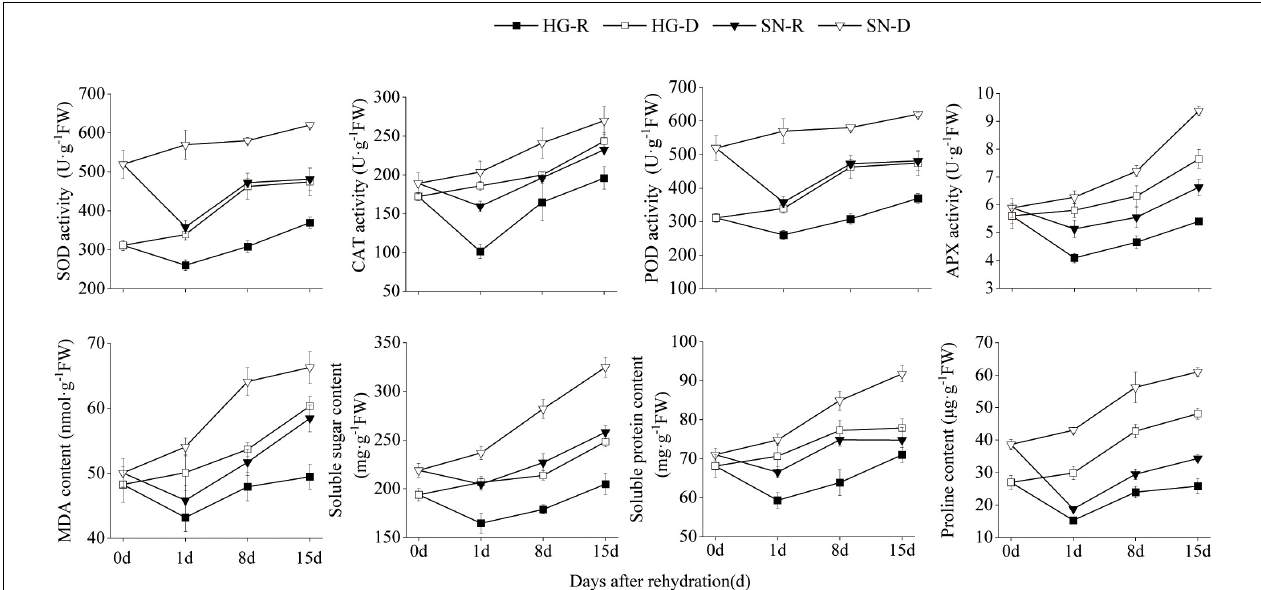
FIGURE 3 | Physiological activities in HG and SN upon rehydration and continuous drought stress. The activity levels of SOD, POD, CAT, and APX in both HG and SN at 0, 1, 8, and 15 dpr were measured. The dynamic changes in contents of MDA, Pro, soluble protein, and soluble sugars in these samples were also monitored.